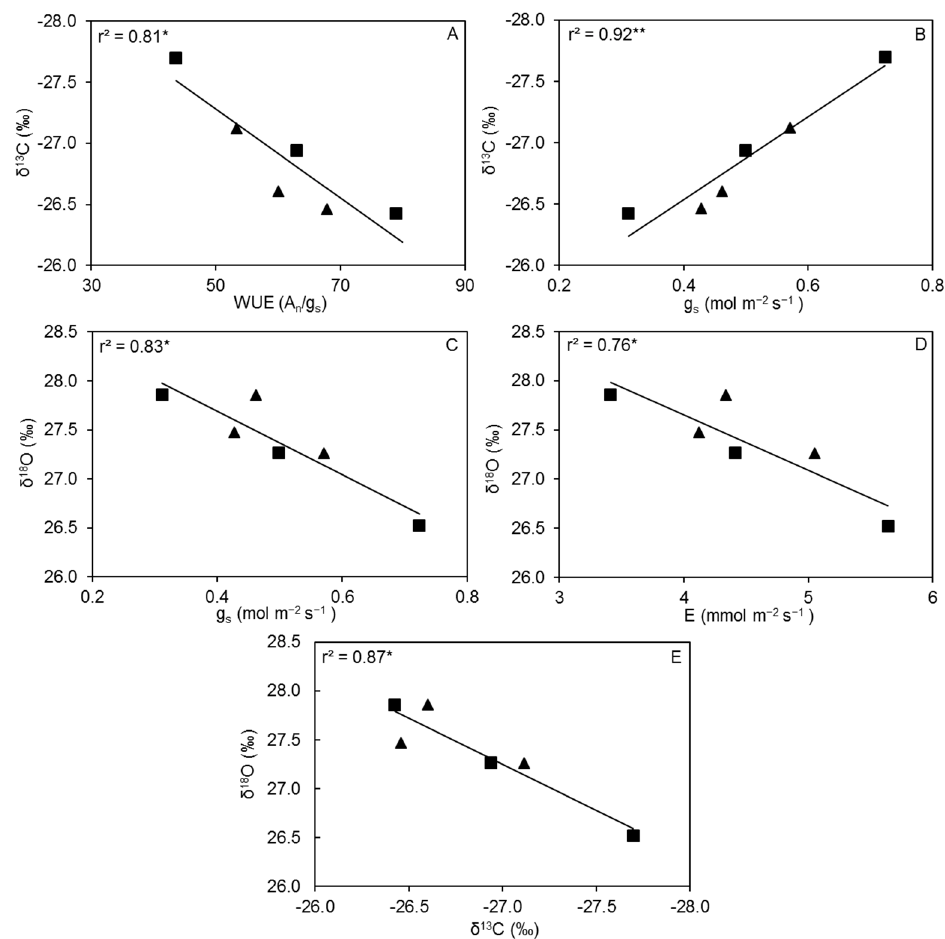
Figure 6. Relationships between ( A ) plant δ 13 C and WUE i , ( B ) plant oxygen isotopic composition ( δ 13 C) and g s , ( C ) plant oxygen isotopic composition ( δ 18 O) and g s , ( D ) plant δ 18 O and E, ( E ) plant carbon isotopic composition ( δ 13 C) and δ 18 O under soil water and inoculation treatments. The solid squares and triangles denote the data points in the inoculated and non-inoculated treatment, respectively. * indicates the significance at p < 0.05, while ** denotes the significance of regression line at p < 0.01.